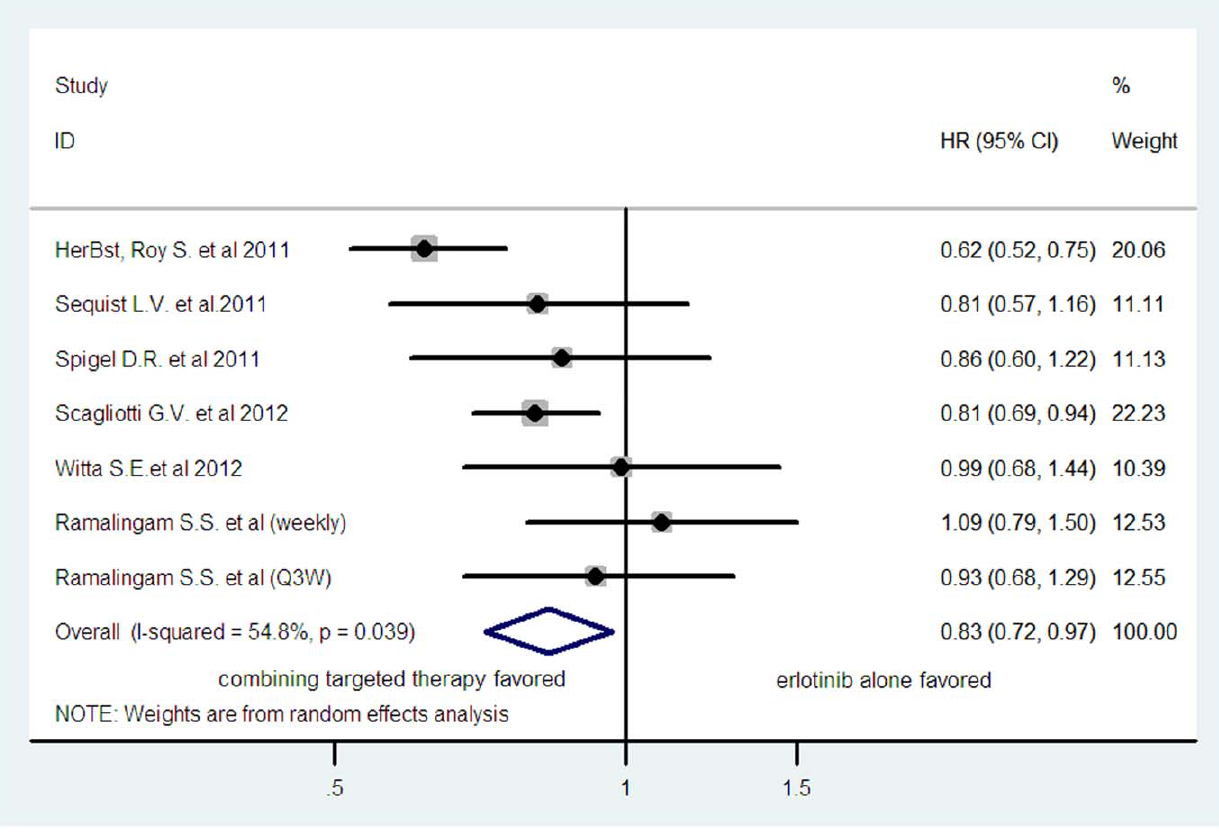
Figure 3. Comparison of PFS between combining targeted therapy and erlotinib alone.